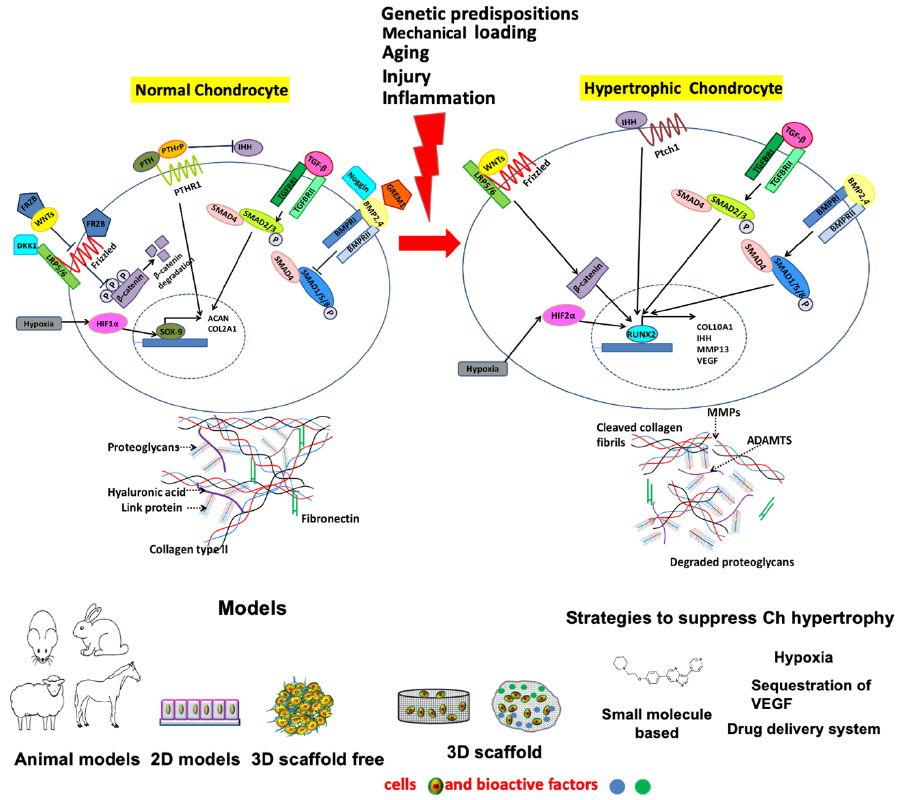
Figure 1. Schematic describing the review summary; the differences in the normal and hypertrophic chondrocyte in terms of active cellular signaling pathways corresponding to healthy ECM and degraded ECM, respectively; models that have been utilized to simulate OA specific hypertrophy; and the basis of the strategies to suppress hypertrophy. 2. Chondrocyte Hypertrophy in OA Healthy articular chondrocytes usually have a reduced proliferation capacity and do not experience terminal differentiation (leading to hypertrophy and apoptosis). Con- versely, chondrocyte hypertrophy and cell death are natural phenomena during em- bryonic development, where chondrocytes undergo active proliferation with consequent enlargement and hypertrophic differentiation. While these chondrocytes grow signifi- cantly in size, the surrounding tissue becomes mineralized and remodels to bone via endochondral ossification [12]. This phenomenon is normal during skeletal growth, but it has also been postulated to be a pathological alteration characterizing hyaline cartilage in OA [19]. During bone development, condensation and differentiation of mesenchymal pro- genitor cells into chondrocytes with the expression of SOX9 and COL2A1 marks the first step of the endochondral ossification program. The differentiated chondrocytes then undergo transient cartilage differentiation: they start to proliferate and express Indian Hedgehog ( IHH), and experience several steps of maturation, with the cells expressing COLX and RUNX Family Transcription Factor 2 (RUNX2 ), which terminally differentiate into hypertrophic chondrocytes expressing osteogenic factors such as ALP and Osteo- pontin ( OPN ). These steps are followed by invasion of the cartilage template by blood